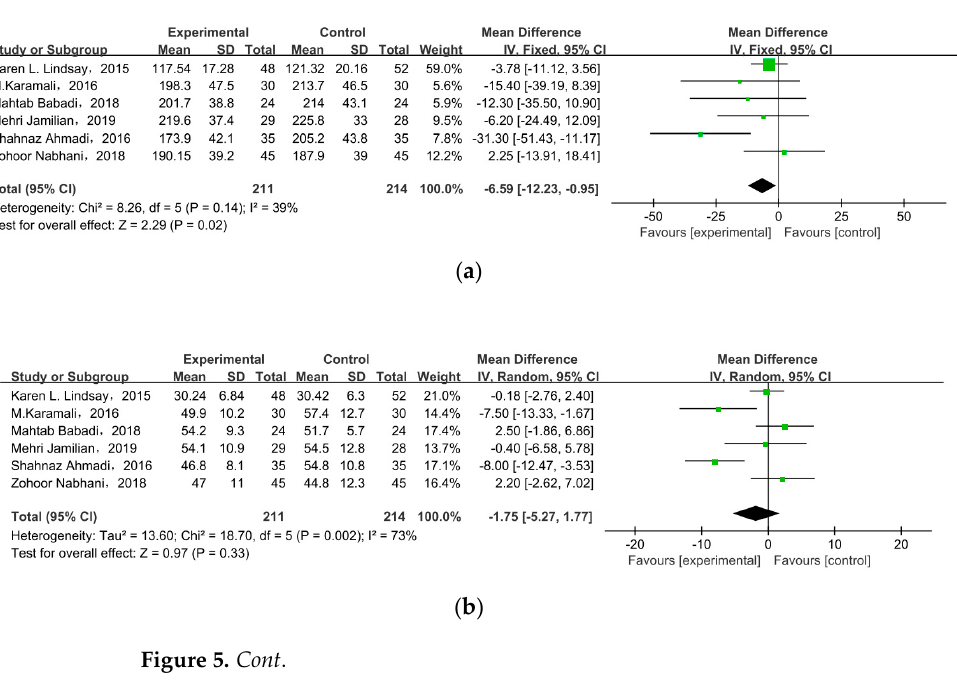
Figure 4. Effect of probiotic supplementation on glucose control in pregnant women with GDM: ( a ) FPG (mg/dL), ( b ) FSI (mU/L), ( c ) HOMA-IR, and ( d ) QUICKI. FPG: fasting plasma glucose; FSI: